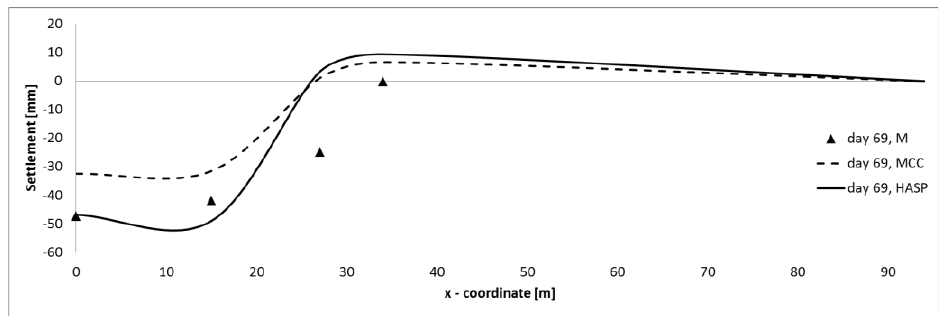
Figure 21. Comparison of the settlement of the ground surface for Embankment B — day 69.